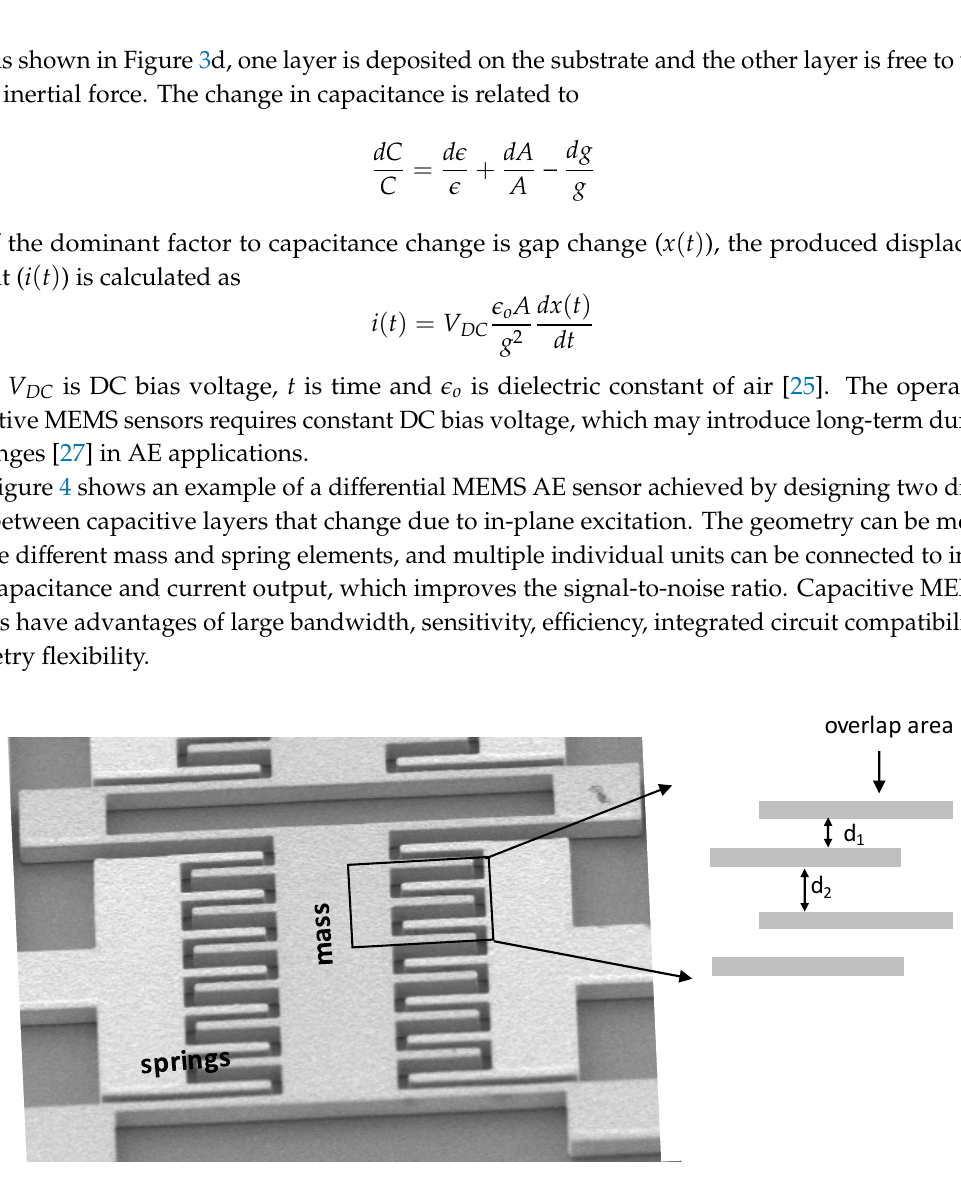
Figure 4. An example of a capacitive MEMS AE sensor for in-plane wave sensing [28].